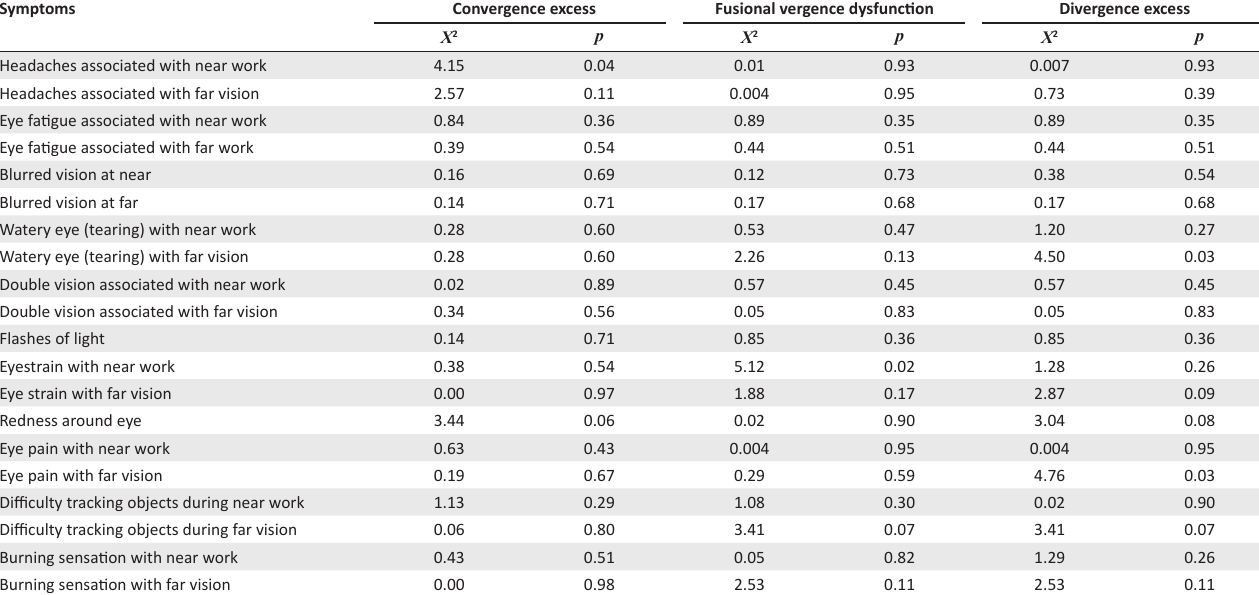
TABLE 3: Association between specific symptomatic vergence disorders and asthenopia in univariate analysis. Symptoms Convergence excess Fusional vergence